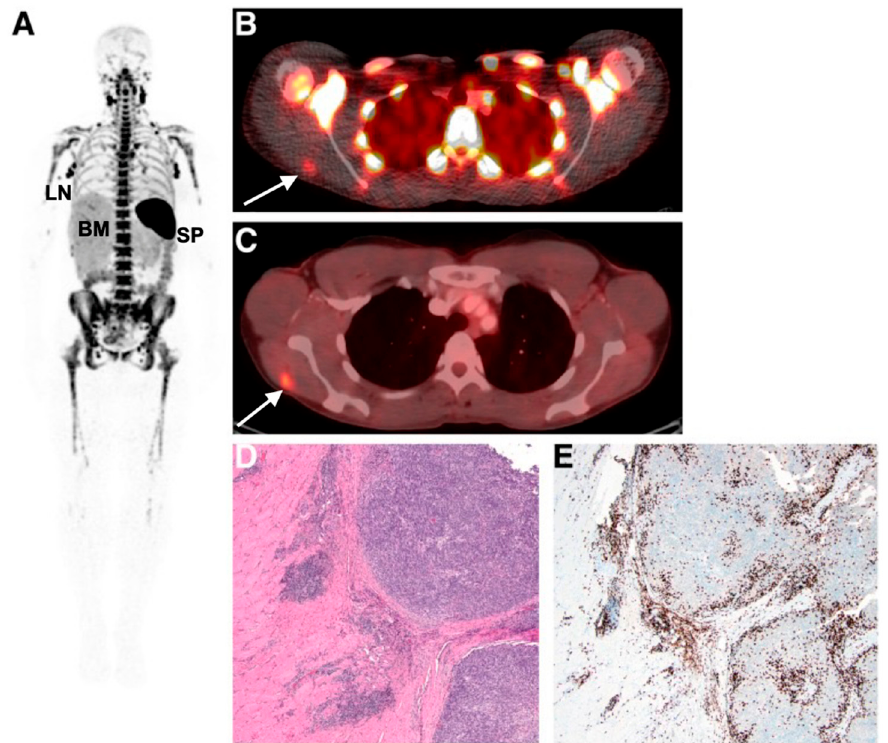
Figure 4. Imaging human T-cell tumour infiltration using [ 89 Zr]Zr-IAB22M2C, a radiolabelled minibody targeting CD8. ( A ) Normal splenic, bone marrow, and lymph node uptake of the tracer were observed. Uptake of ( B ) [ 89 Zr]Zr-IAB22M2C and ( C ) [ 18 F]FDG in a melanoma metastasis in the deltoid muscle of a patient was histologically confirmed as high CD8 + T-cell infiltration ( D , E ). Figure reproduced from [87].